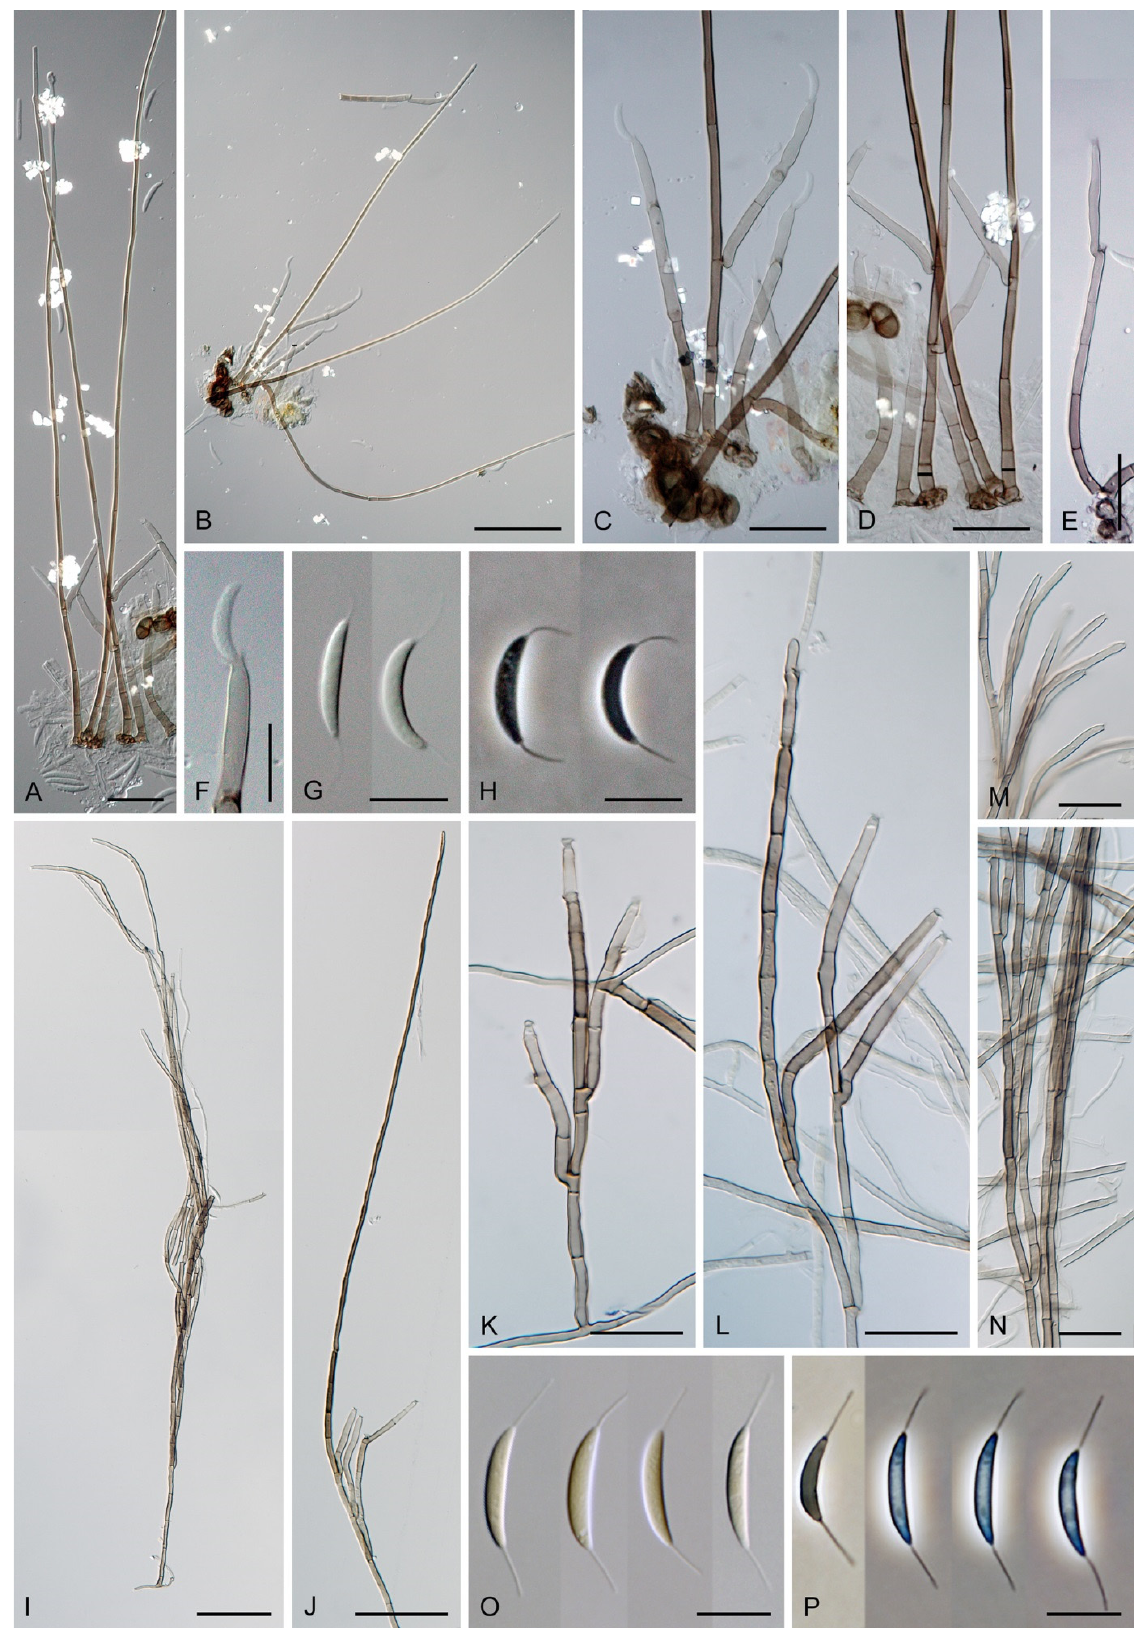
Figure 21. Codinaeella filamentosa (CBS 147265). ( A – E , I – N ) Conidiophores ( F ) conidiogenous cell ( G , H , O , P ) conidia. Images: ( A – H ) from nature ( I – P ) on MLA after 4–8 weeks. Scale bars: ( A ) 20 μ m; ( B , I , J ) 50 μ m; ( C – E , K – N ) 20 μ m; ( F – H , O , P ) 10 μ m.